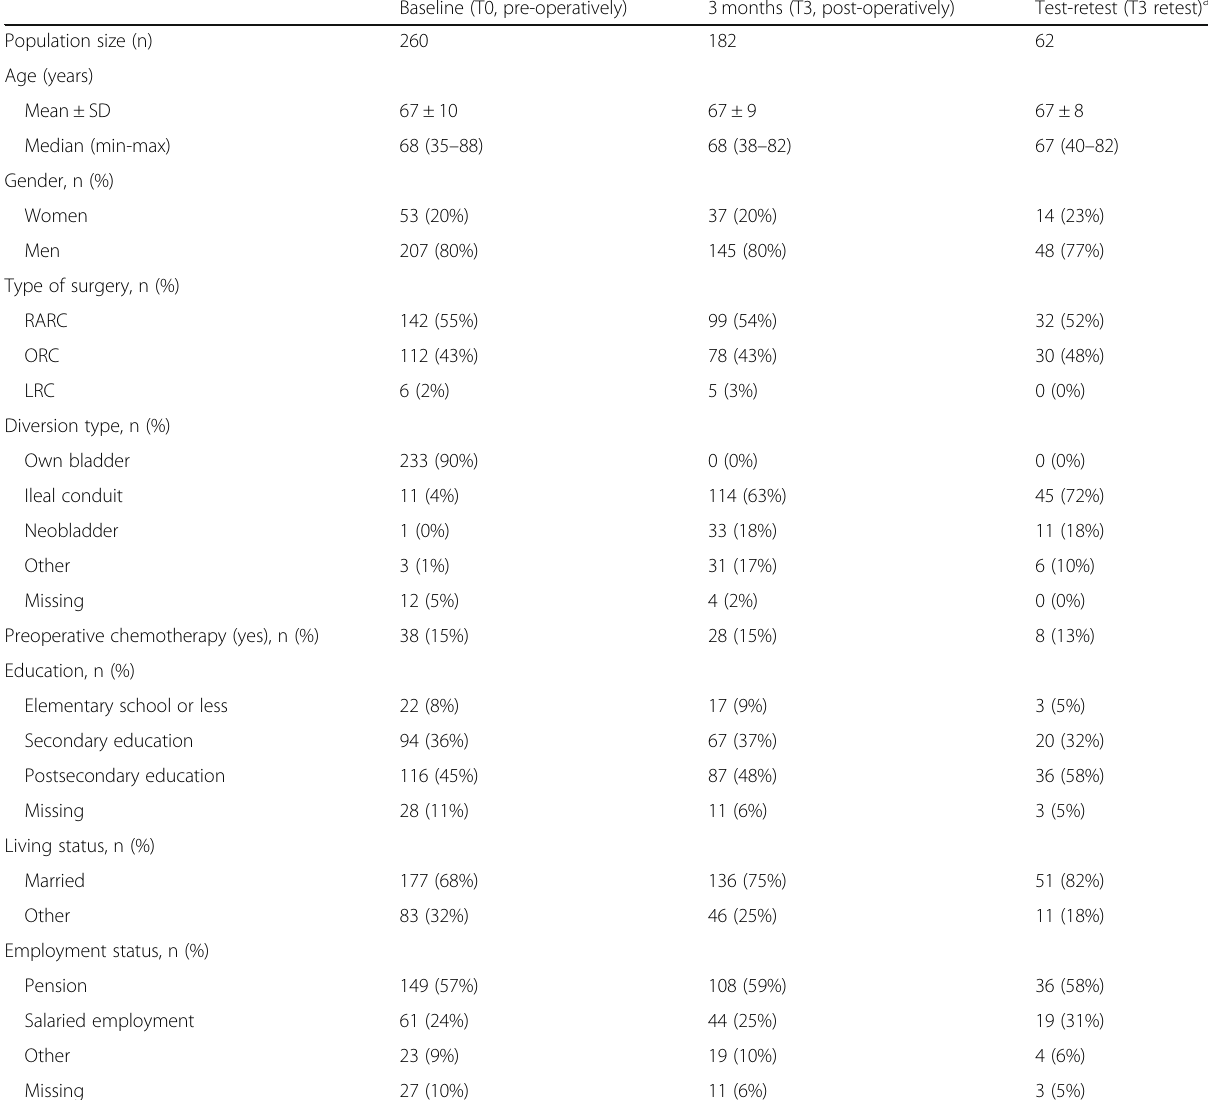
Table 1 Patient characteristics of the test and re-test groups